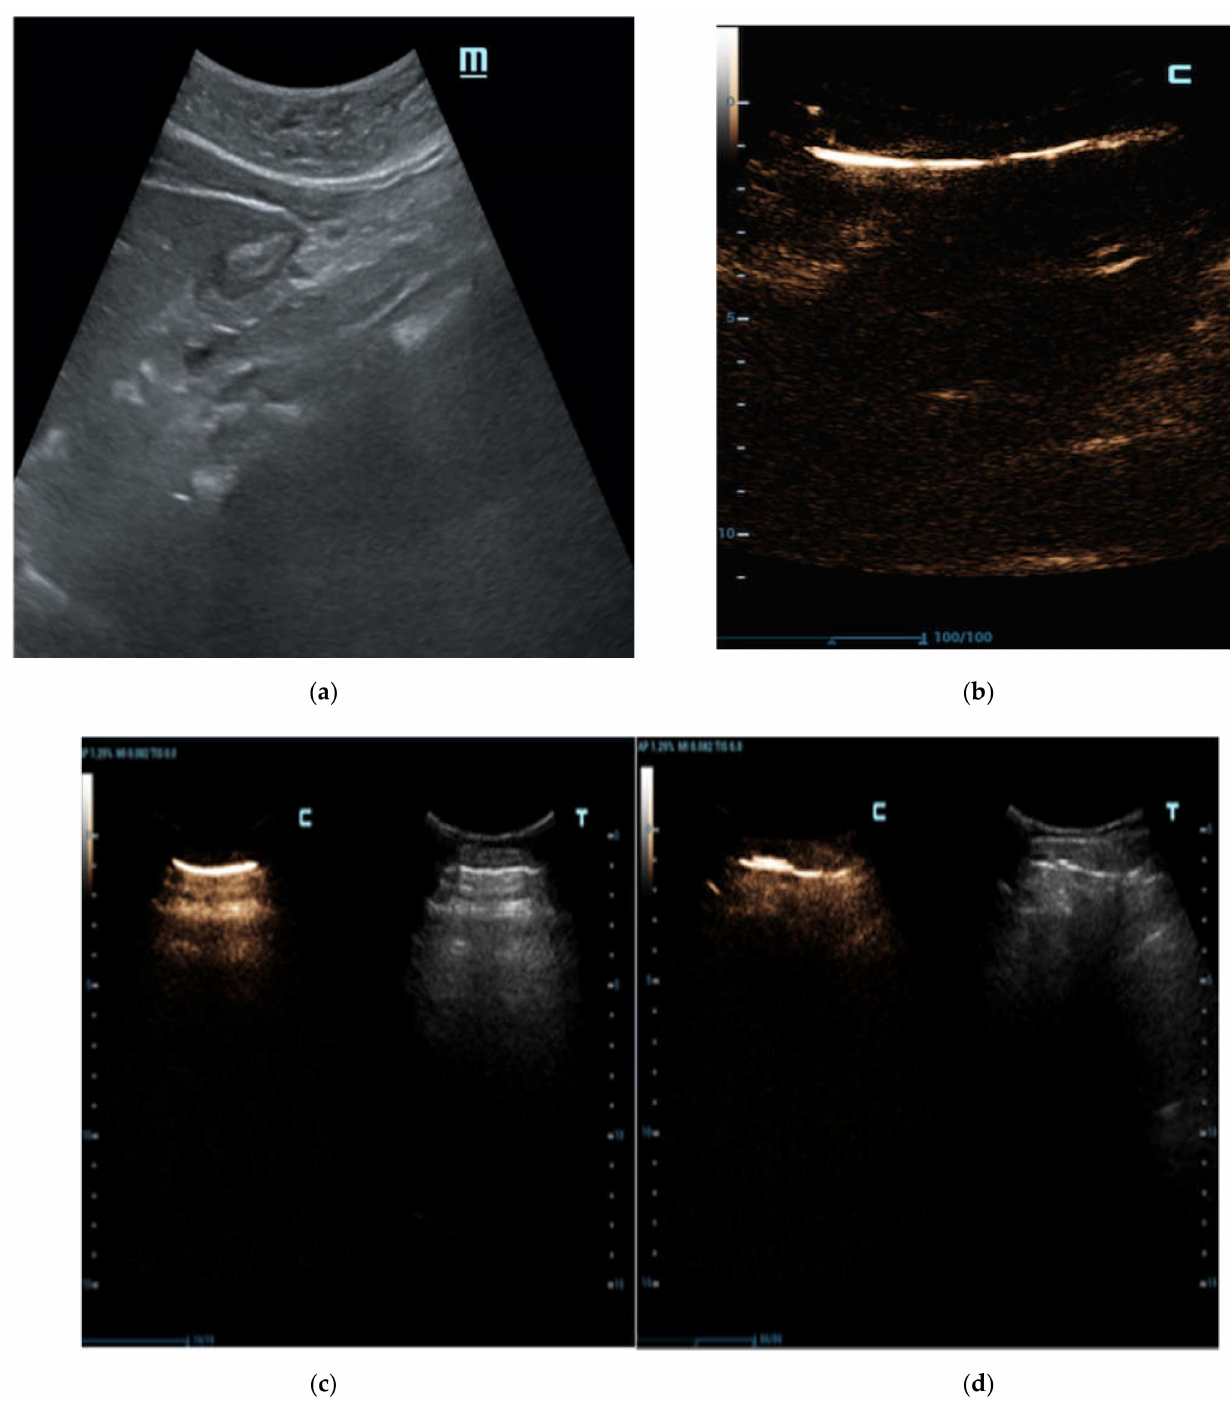
Figure 5. Black male patient, 29 years old with acute abdominal pain; no comorbidities were noted at the time of E.D. access and radiologic evaluation. ( a ) Longitudinal sub-hepatic US scan of liver. Air under the abdominal wall was erroneously interpreted as hyper-echogenicity in correspondence with B-mode’s anatomic interface; ( b ) C-mode demonstrated its ability to distinctly reveal highlighted lines in correspondence to the pre-hepatic space. ( c ) Transverse abdominal US scans show the peritoneal plane under anterior abdominal wall. C-mode distinctly reveals intensely highlighted lines of brightness under the abdominal wall; ( d ) the peritoneal stripes’ appearance is modified when the patient’s position is changed at the radiologist’s